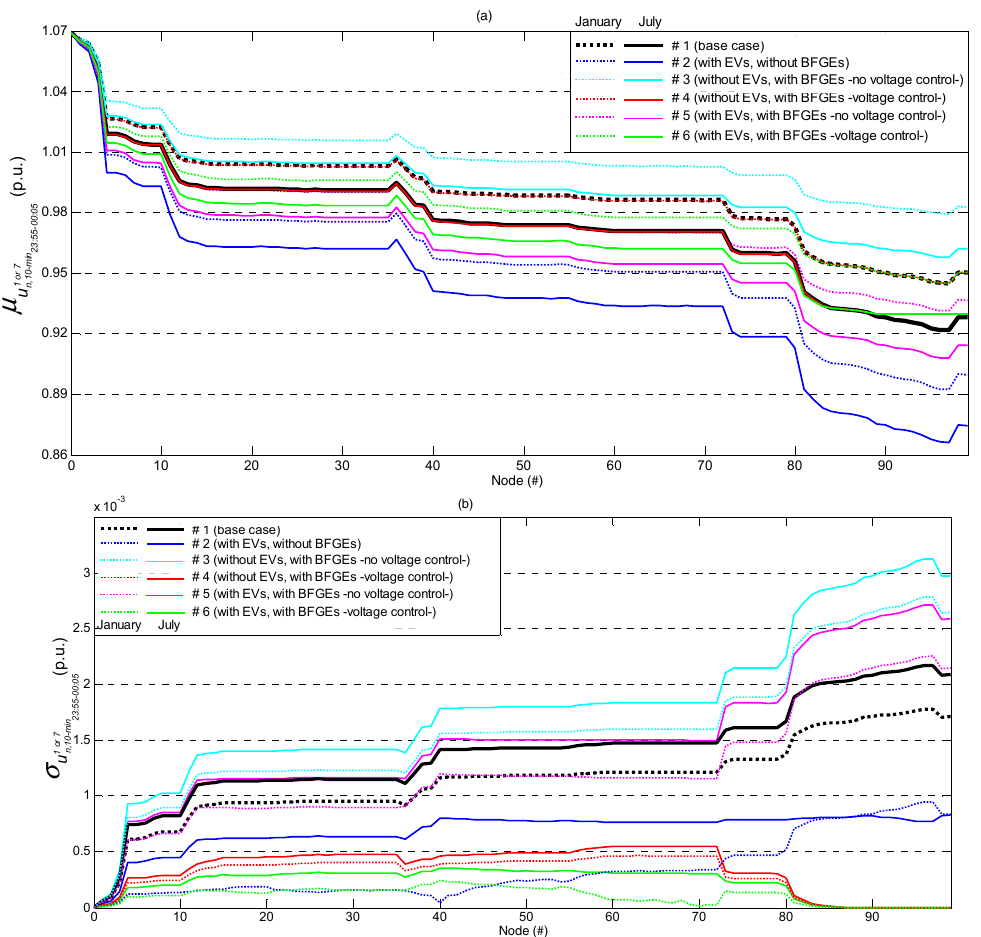
Figure 6. 10-min voltage magnitude during a working day in January and July for each RDS node in different scenarios around 00:00 h. ( a ) expected value; ( b ) standard deviation.